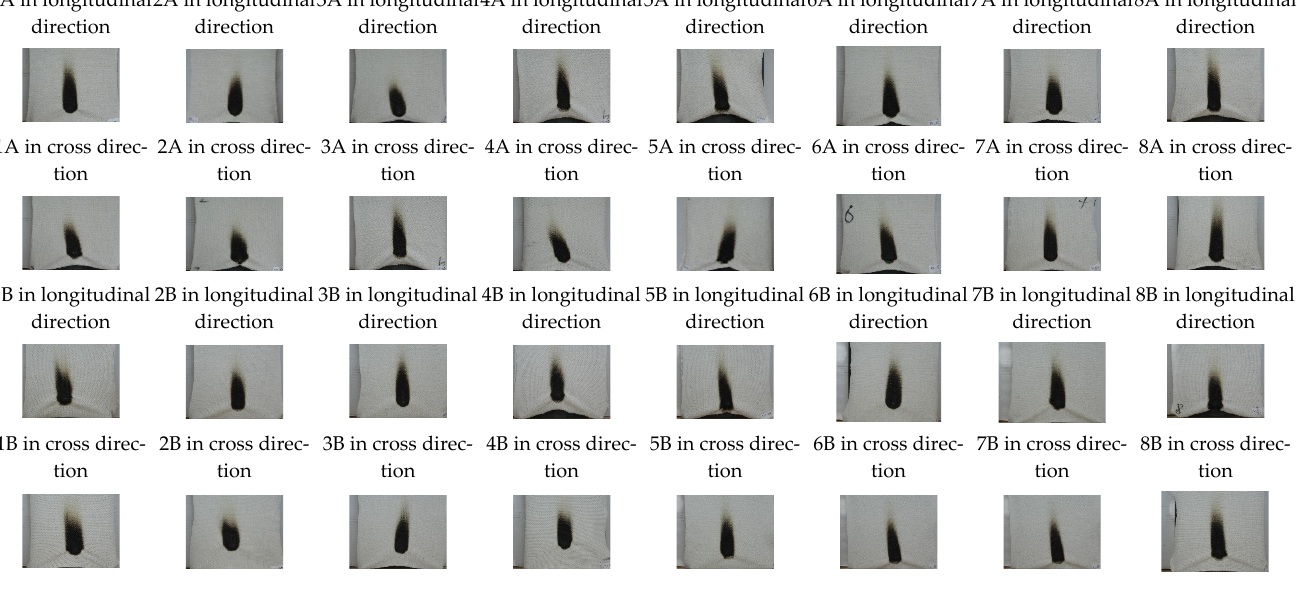
Figure 12. Charred area images after flame application to the fabrics